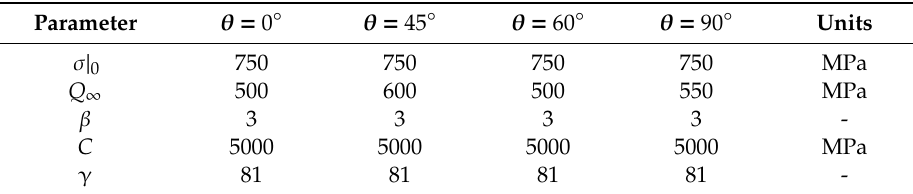
Table 3. Determination of the parameters for the fracture